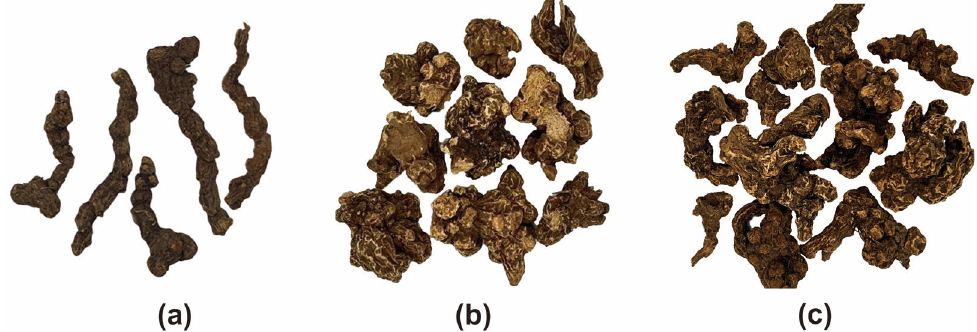
Figure 1. Wild and cultivated RAL. ( a ) Wild RAL; ( b ) cultivated RAL (Mao Mountain); ( c ) cultivated RAL (Yingshan).